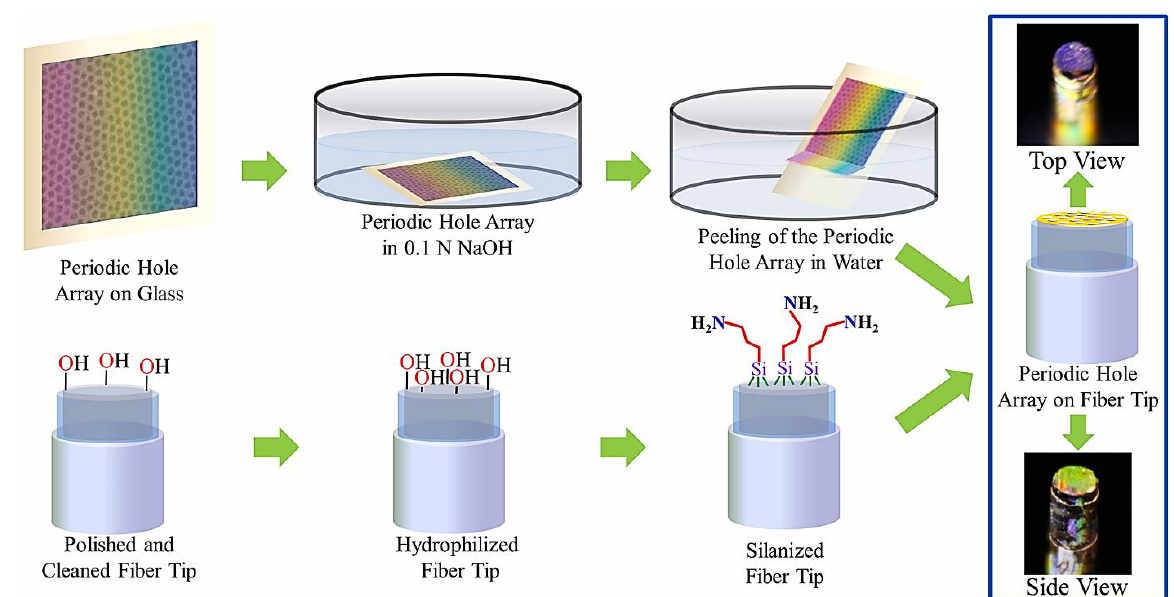
Figure 5. Process used to prepare fiber-optic plasmonic sensors. A periodic hole array in a gold film is fabricated on a flat glass substrate using solely chemical methods. Subsequently, this hole array is lifted off from the substrate surface by immersing it in a basic solution. The hole array film detaches from the substrate surface and starts floating on the water surface. The periodic hole array in a gold film can be picked up with an appropriately functionalized optical fiber tip. Photographs of the resulting fiber-optic plasmonic sensors are shown on the right. The figure in Polley et al. [53] is reprinted with permission from Elsevier.